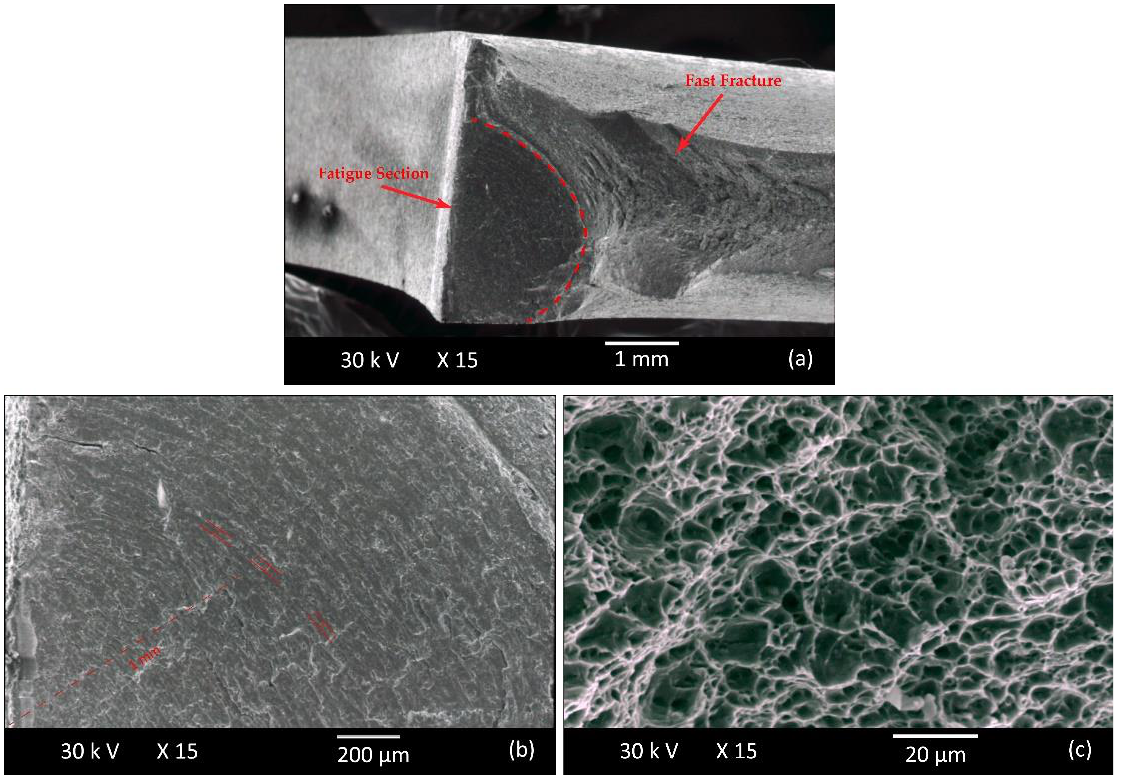
Figure 7. ( a ) Fracture surfaces with ( b ) fatigue and ( c ) fast fracture sections.